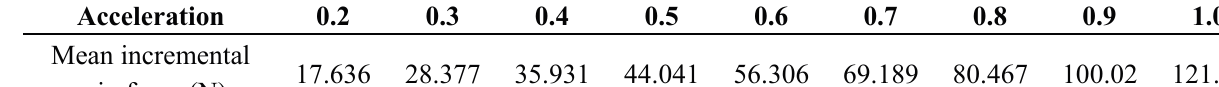
Table 5. Incremental grip force vs. acceleration.